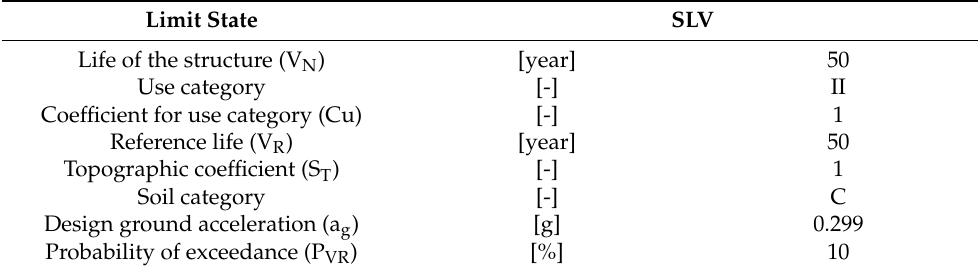
Table 2. Seismic parameters.